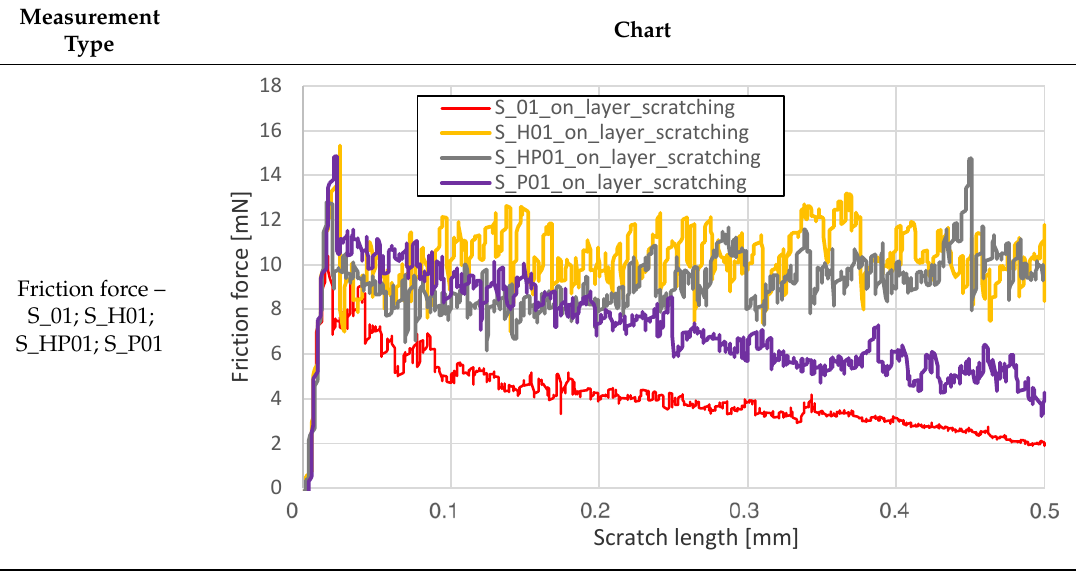
Figure 3. Friction forces observed while scratching the S_01 series samples before and after HIP.